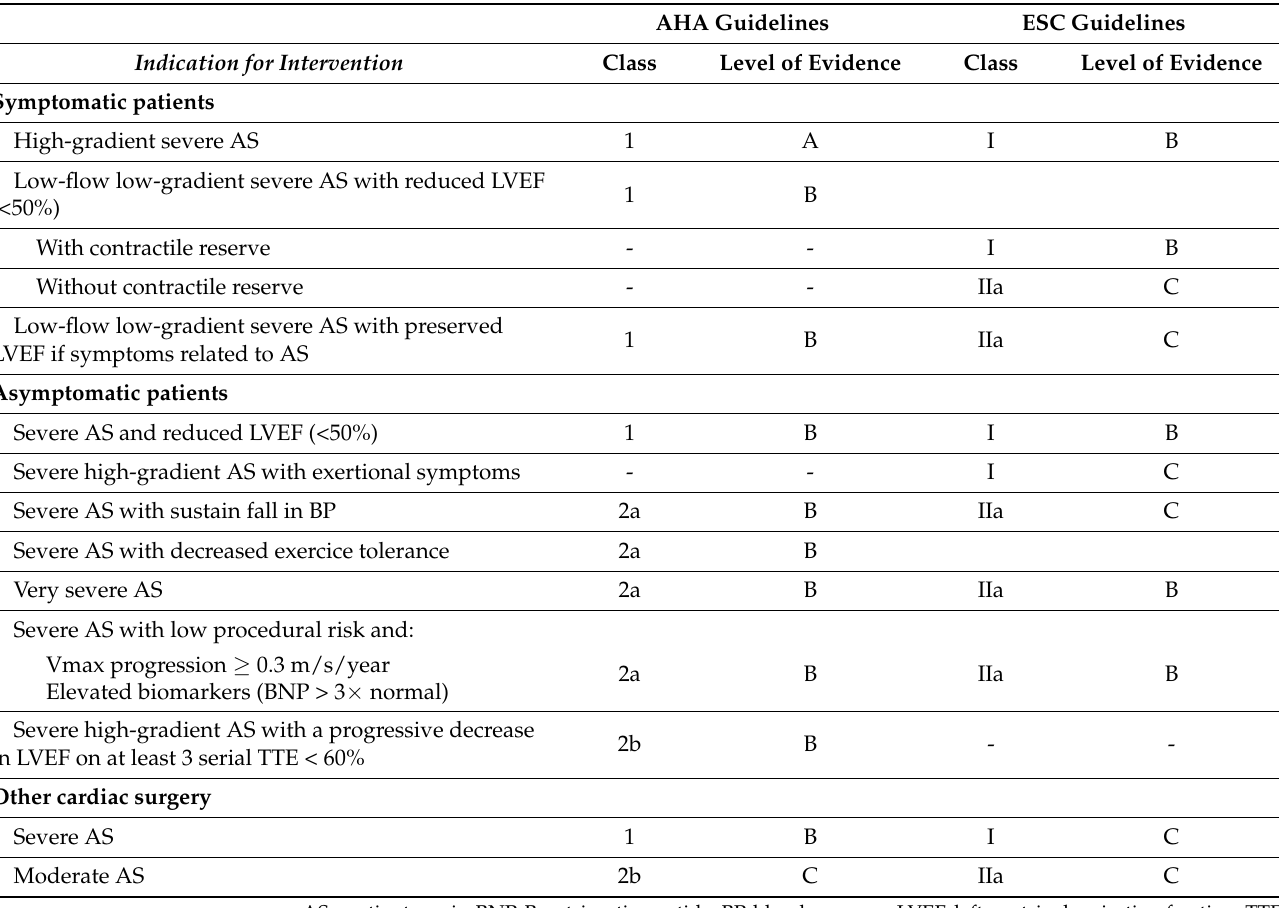
Table 1. Indication for invasive management of aortic stenosis.